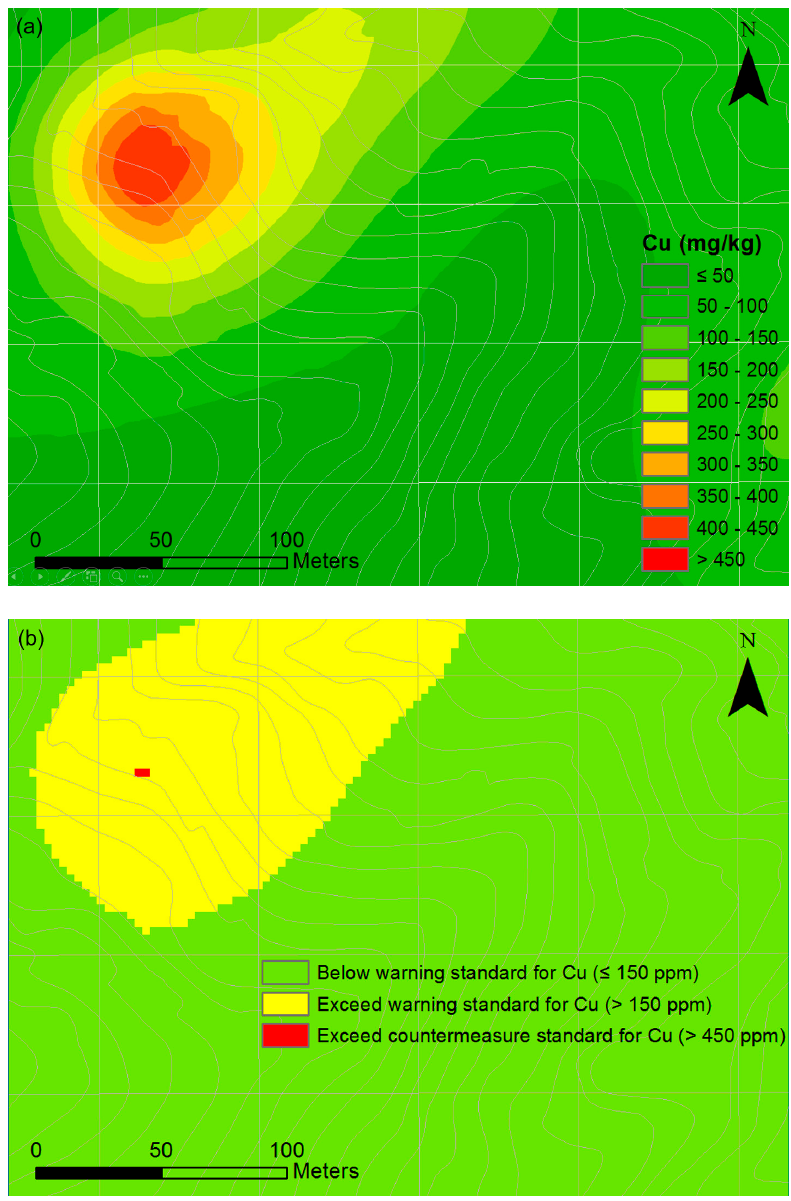
Figure 9. Soil contamination map. ( a ) Spatial distribution map of Cu; ( b ) Areas with high levels of soil contamination exceeding the Korea Soil Contamination Warning Standards or Countermeasure